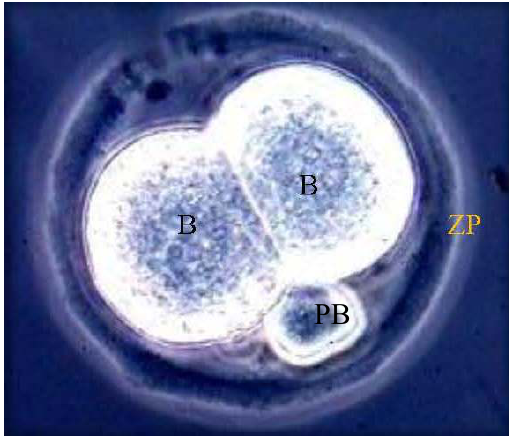
Figure 1. Normal 2 - cell embryo with two equal blastomeres (B), one of two polar bodies (PB) encompassed by an intact zona pellucida (ZP; magnification =